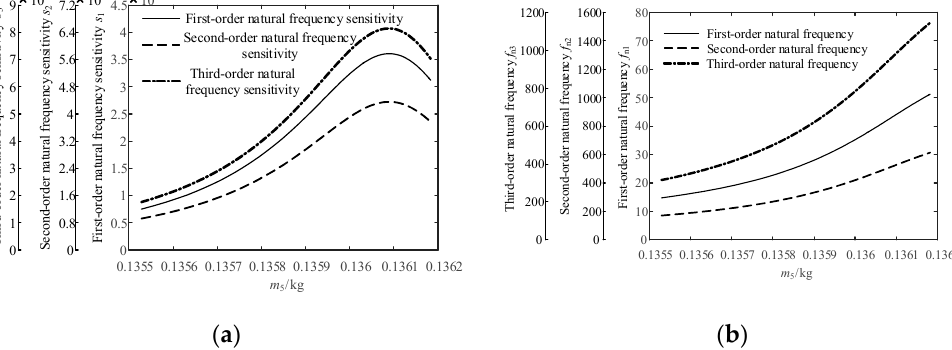
Figure 11. The variation law of the first three natural frequencies and their sensitivities of the jet system under a different pressure of the fluid with the mass of fluid unit 2. ( a ) Variation law of natural frequency sensitivity. ( b ) Variation law of natural frequency.